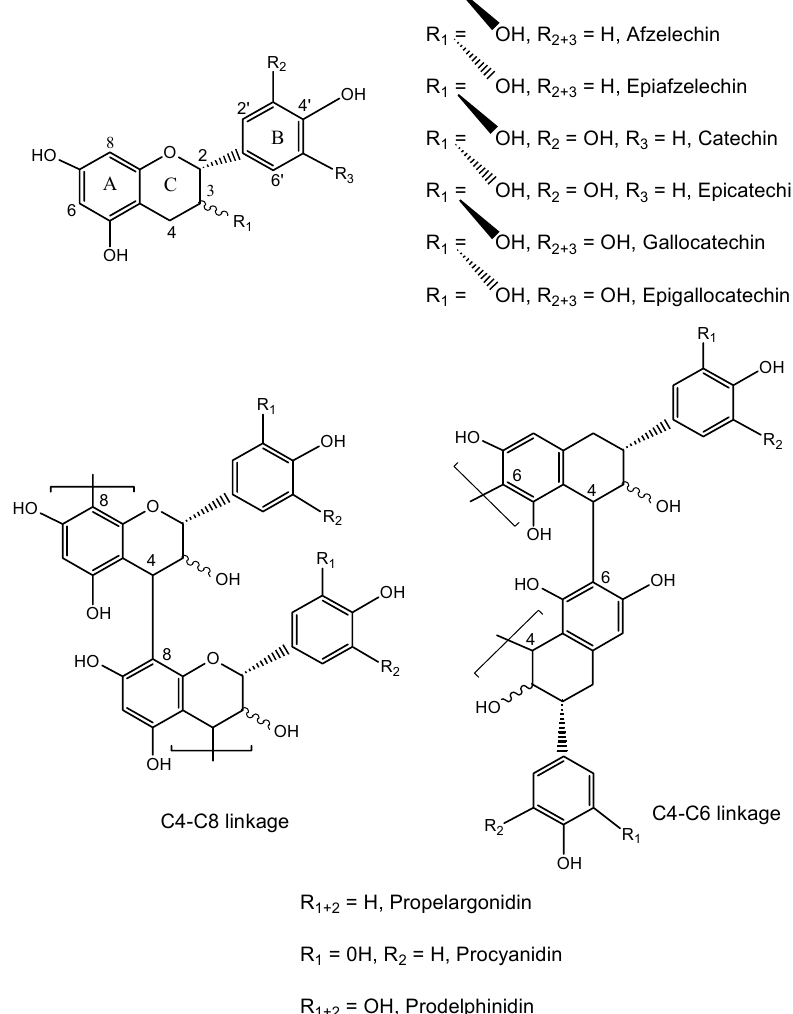
Figure 1. Chemical structure of fl avan-3-ol monomer units and condensed